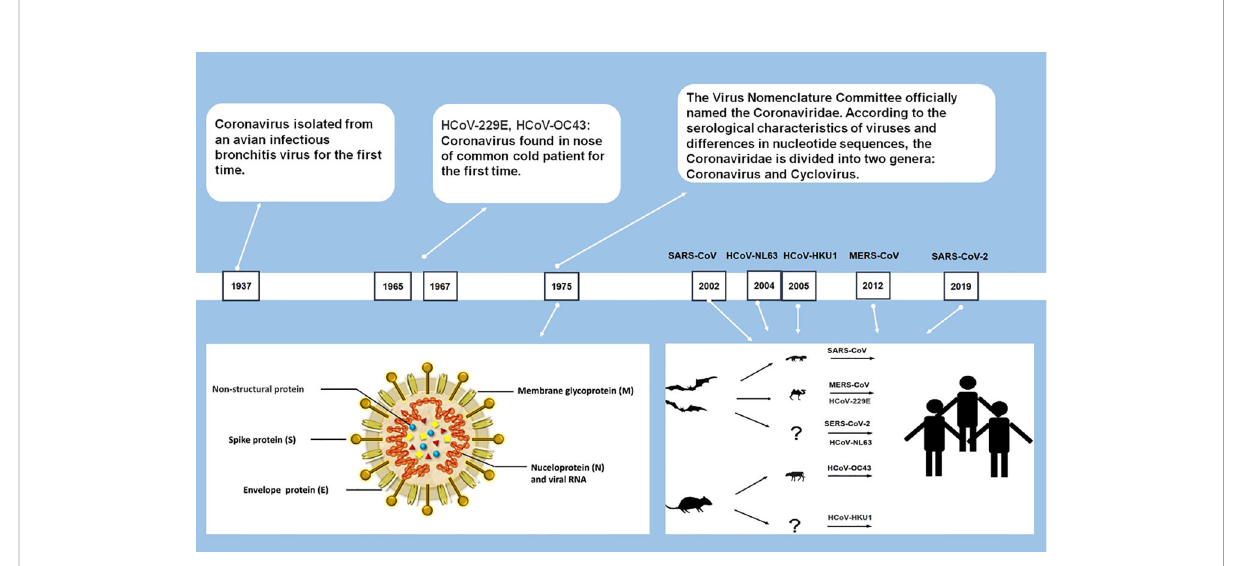
FIGURE 1 Human Coronavirus: Discovery Timeline, Structure and